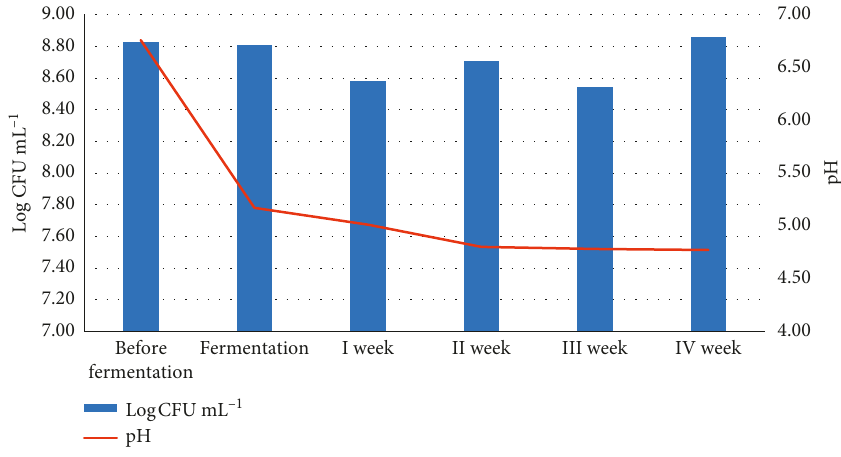
Figure 2: pH and viability in fermented skim milk during